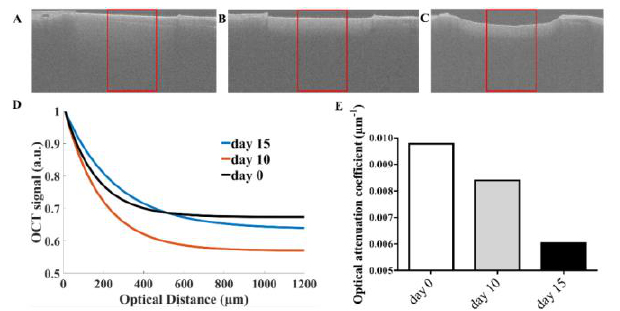
Figure 1. Representative Optical Coherence Tomography (OCT) images collected from untreated dentine at day 0 ( A ), 10 ( B ), and 15 ( C ). Numerical fits calculated from OCT signals extracted from regions delimited by red polygons in each image are shown in D . OAC values calculated from each numerical fit are depicted in E .